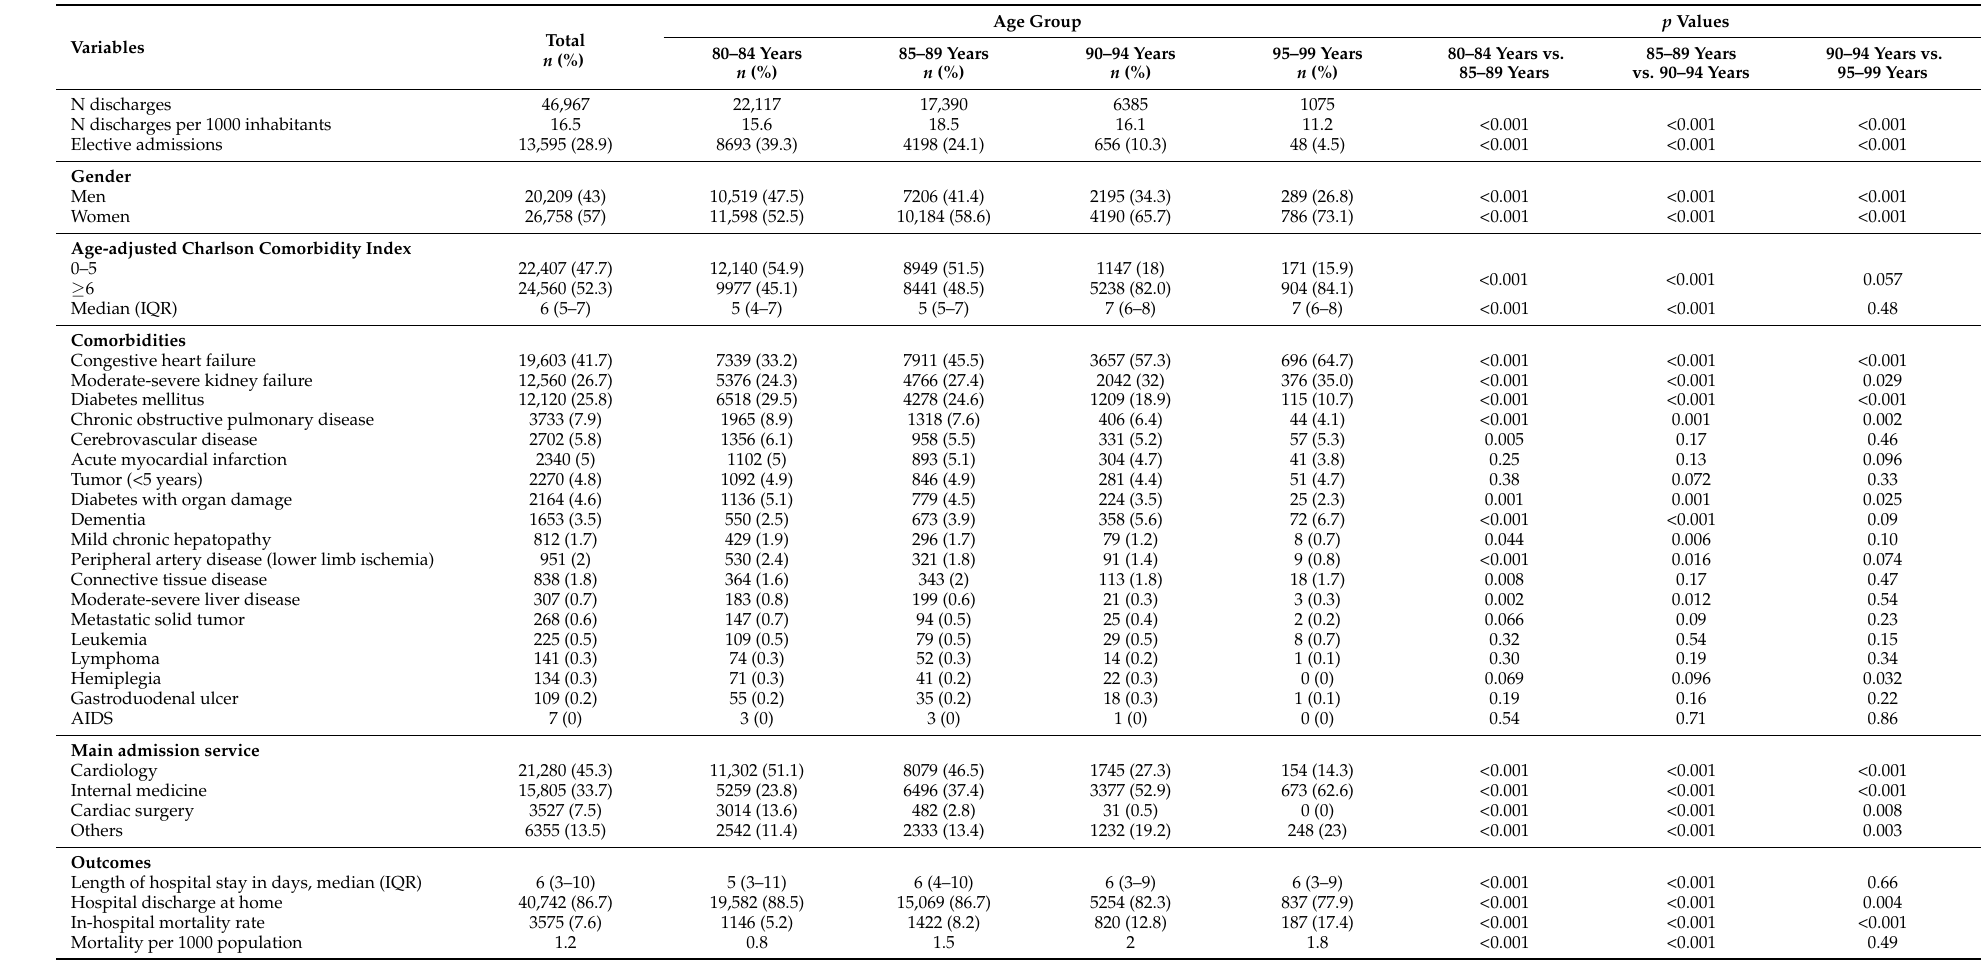
Table 1. Epidemiological characteristics, comorbidities, and outcomes in discharged patients with aortic stenosis, by age